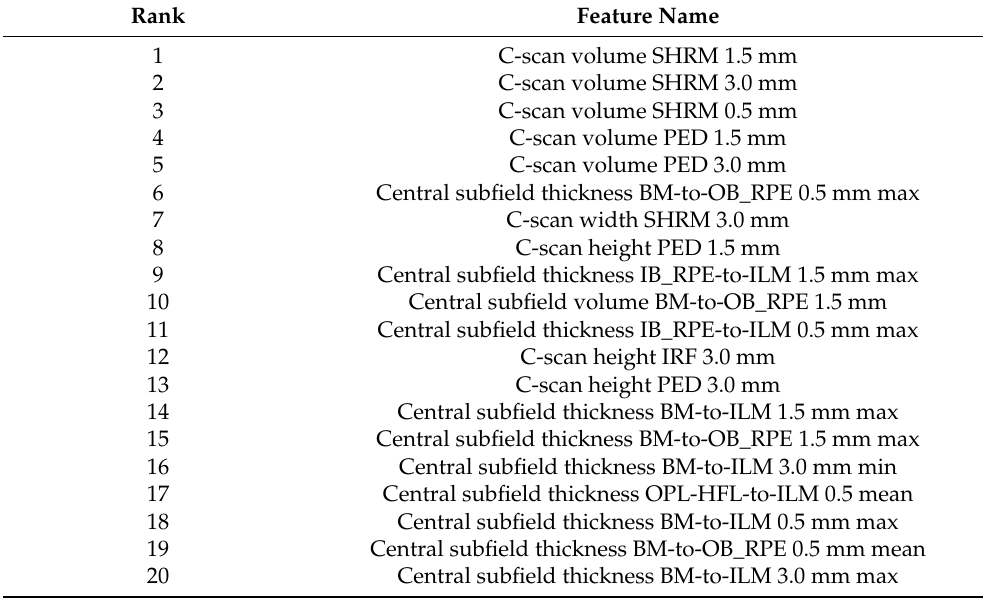
Table 7. The top 20 features from Figure 6 in descending order of importance.